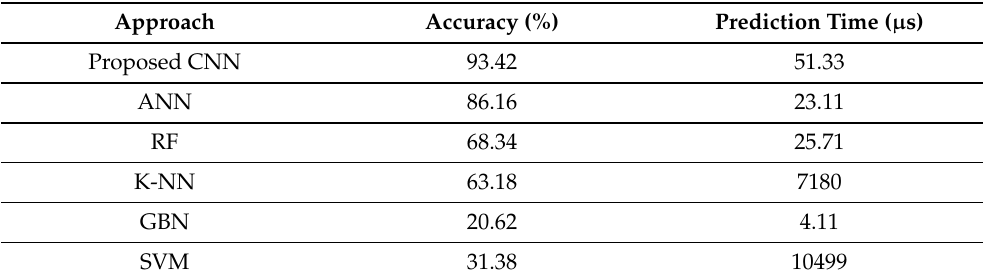
Table 4. Classification accuracy and average prediction time comparison for LTS approach.